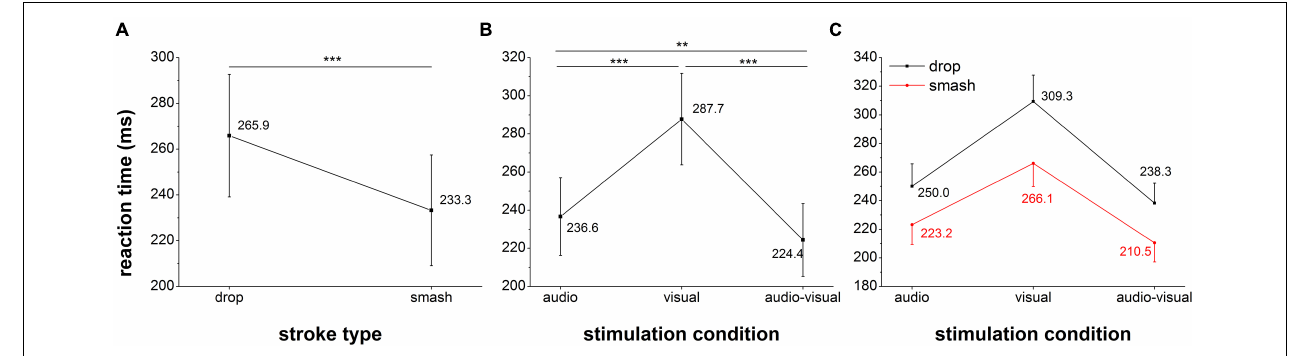
FIGURE 3 | Reaction time analysis for the factor stroke type (A) , stimulation condition (B) and the interaction between both factors (C) . Error bars reflect 95% confidence intervals. **: p < 0.01, ***: p < 0.001.